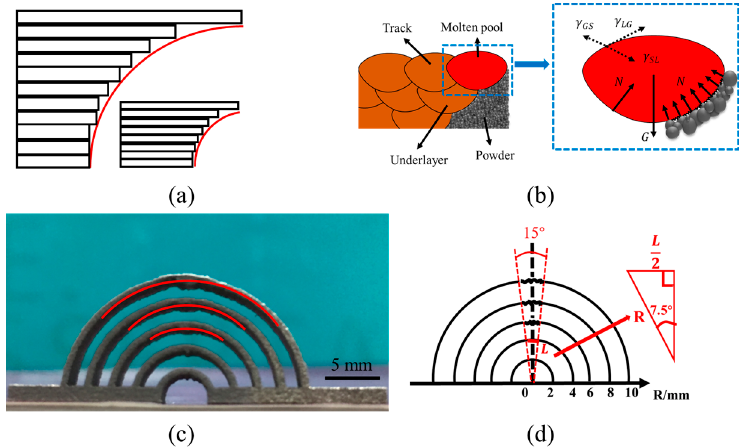
Figure 7. ( a ) Length change of overhangs of arched structures of different radius during SLM process; ( b ) the force acting on the liquid metal in molten pool; ( c ) photos of arched bridge structure manufactured by SLM; ( d ) the collapsed area at the top of the concentric circle varies with different radius of arched bridge structures.